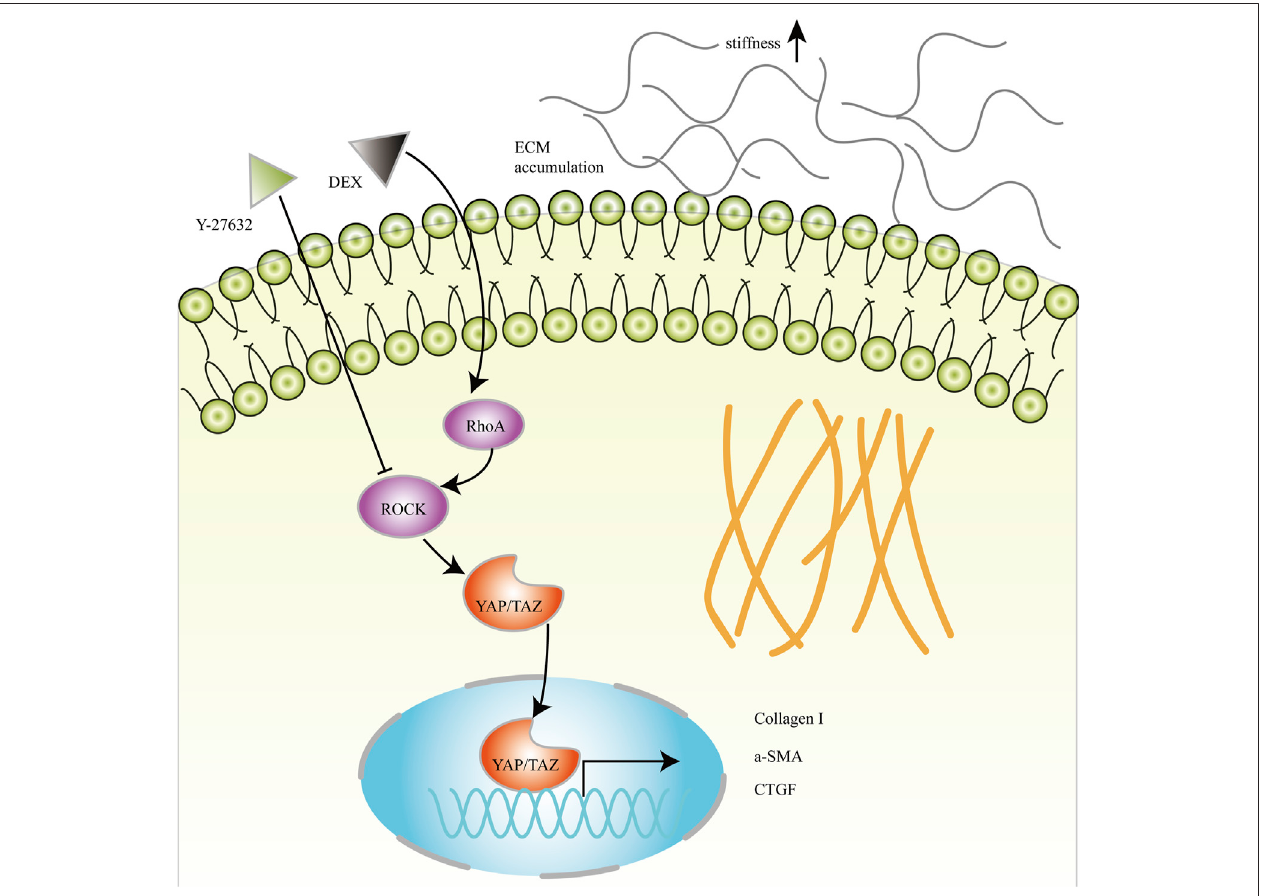
FIGURE10| SchematicdiagramofRhoA/ROCKandYAP/TAZmediated fi broticactivityinDEX-treatedHTMcells.RhoA/ROCKactivatedbyDEXinducesnuclear translocation of YAP/TAZ, which leads to an increase of Collagen I, myo fi broblast biomarker α -SMA, and CTGF. Aberrant ECM accumulation and remodeling may increase the elastic modulus of HTM